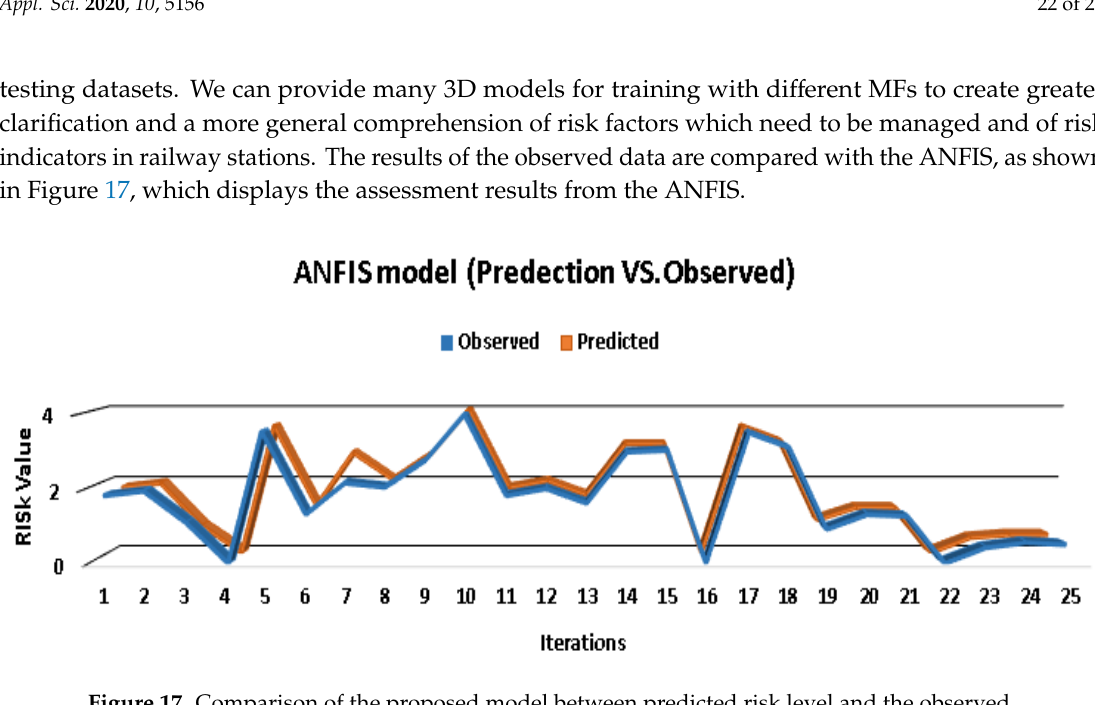
Figure 17. Comparison of the proposed model between predicted risk level and the observed.